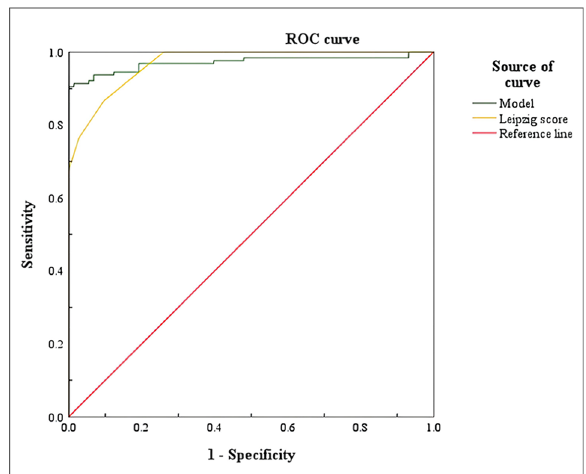
FIGURE 5 Comparison of ROC curves of Wilson ’ s disease prediction model and Leipzig score. ROC, receiver operating